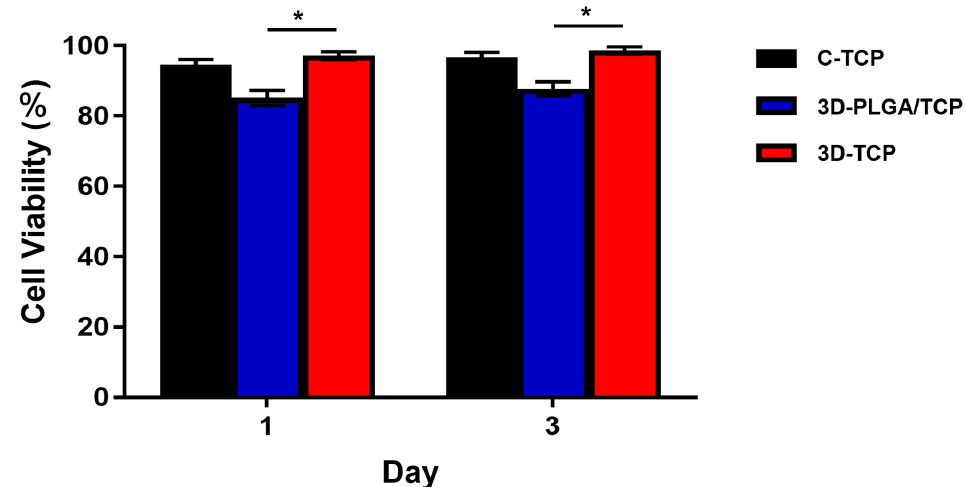
Figure 5. hDPSCs viability of C-TCP, 3D-PLGA / TCP, and 3D-TCP sca ff olds. C-TCP and